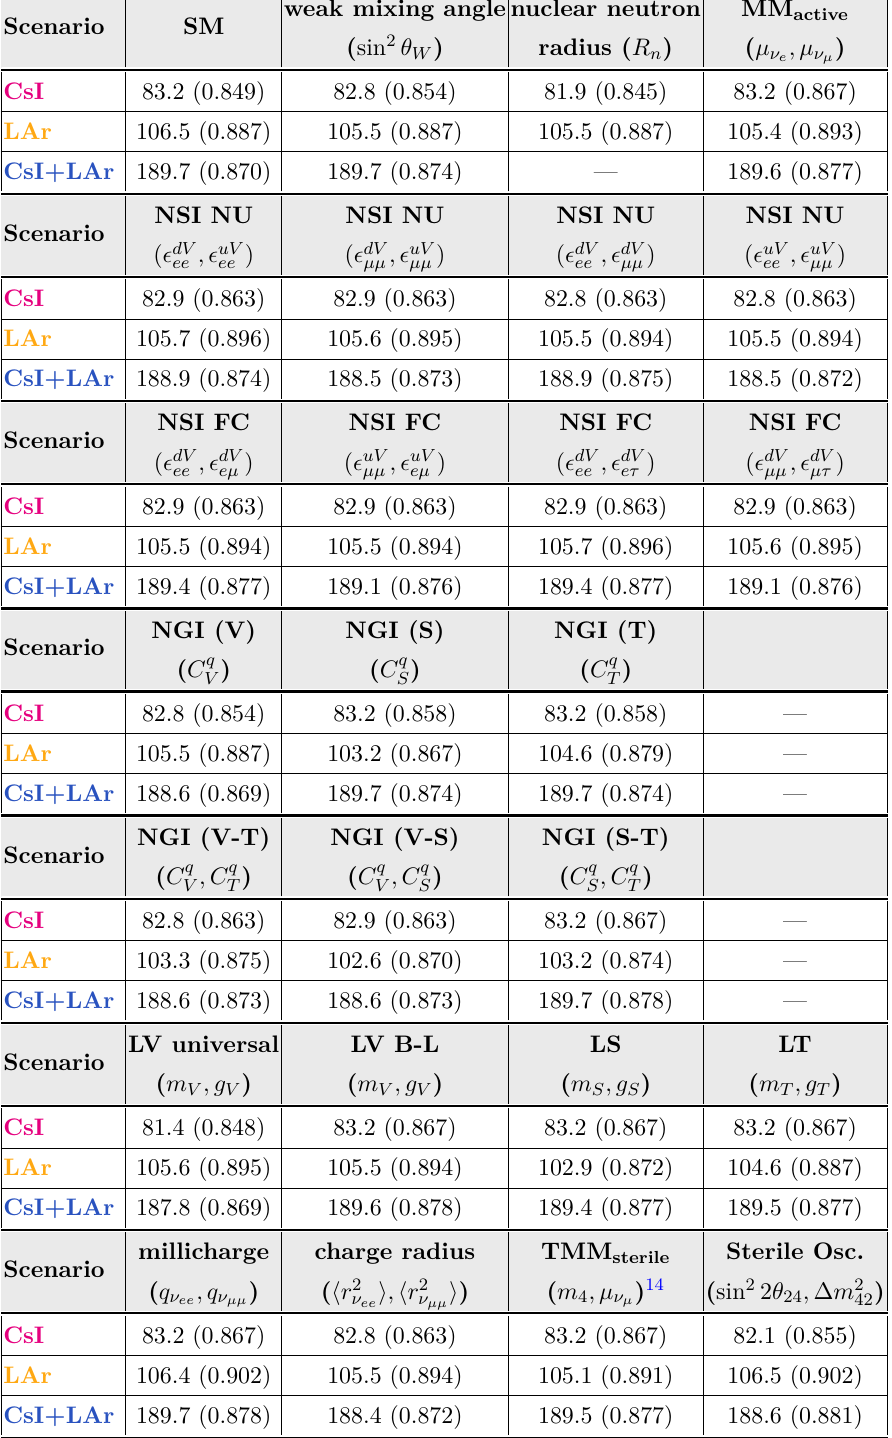
values for the various physics scenarios analyzed in the present work, in parenthesis Table 2 . χ 2 min normalized to # in each dof